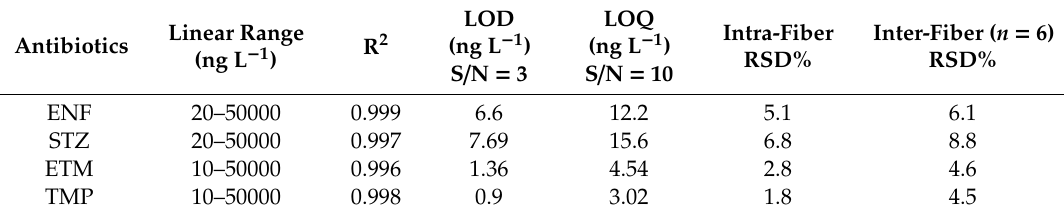
Table 1. Linear ranges (ng L − 1 ), linear regression coe ffi cient (R 2 ), LOD (S / N = 3, ng L − 1 ), LOQ (S / N = 10, ng L − 1 ) and intra-fiber and inter-fiber reproducibility (%) of the custom-made fiber ( n = 6) in water